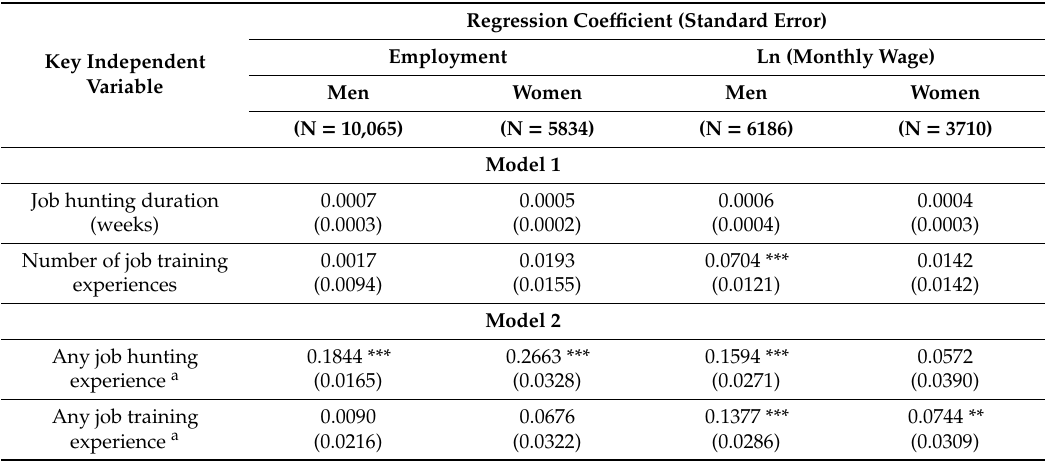
Table 2. Marginal e ff ect of job e ff orts on labor market outcomes: individual-level fixed-e ff ects models.